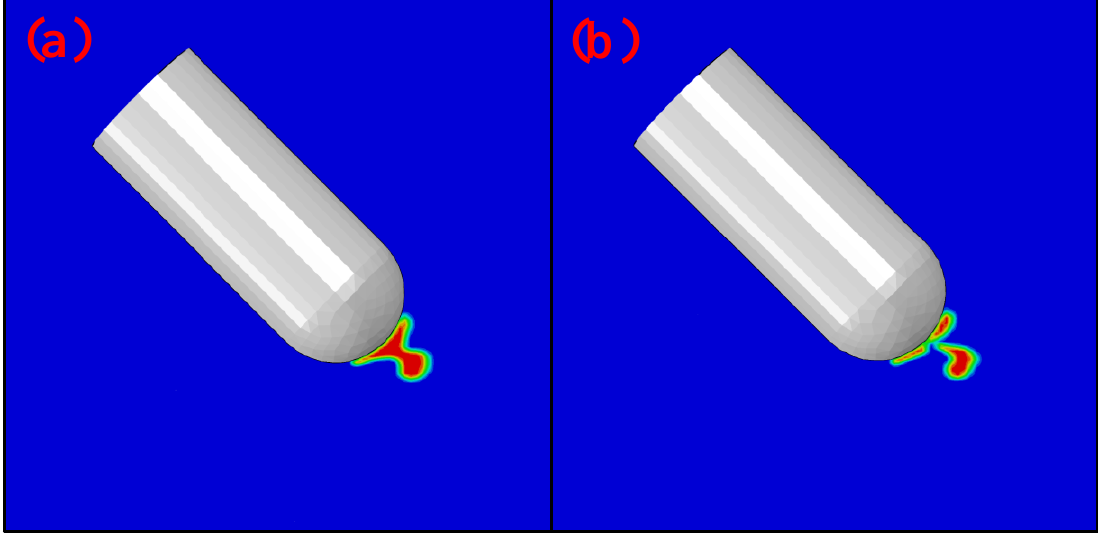
Figure 18. When ζ = 1.2 and γ = 0.33, the first period of contraction of the bubble is simulated by ABAQUS/Explicit. The bubble collapse load and jet load were caused by the bubble pulsation process.